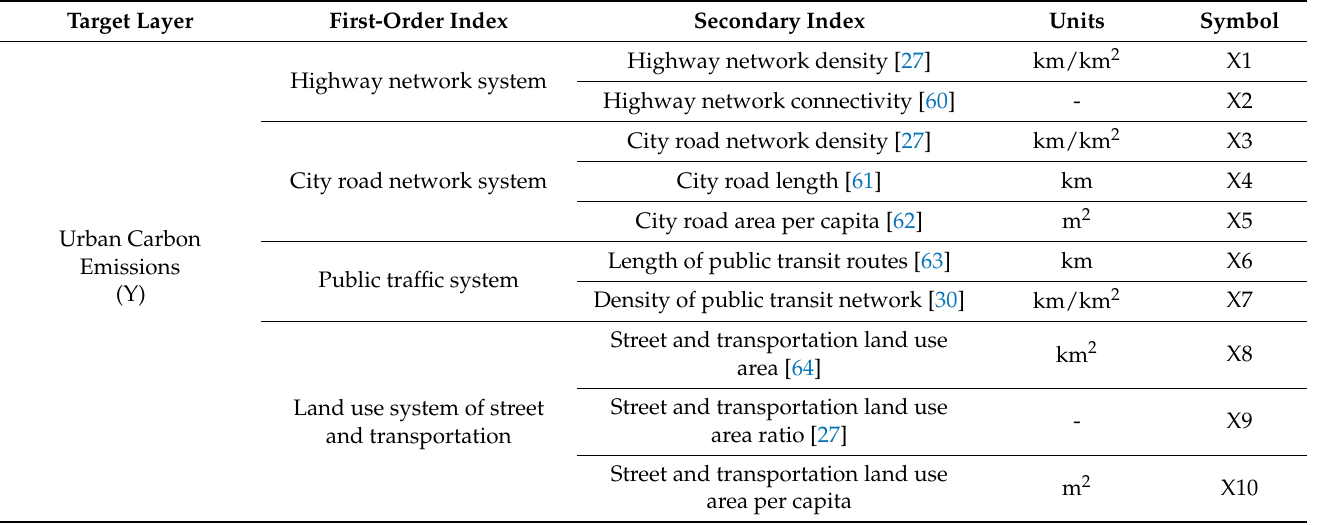
Table 1. Road traffic